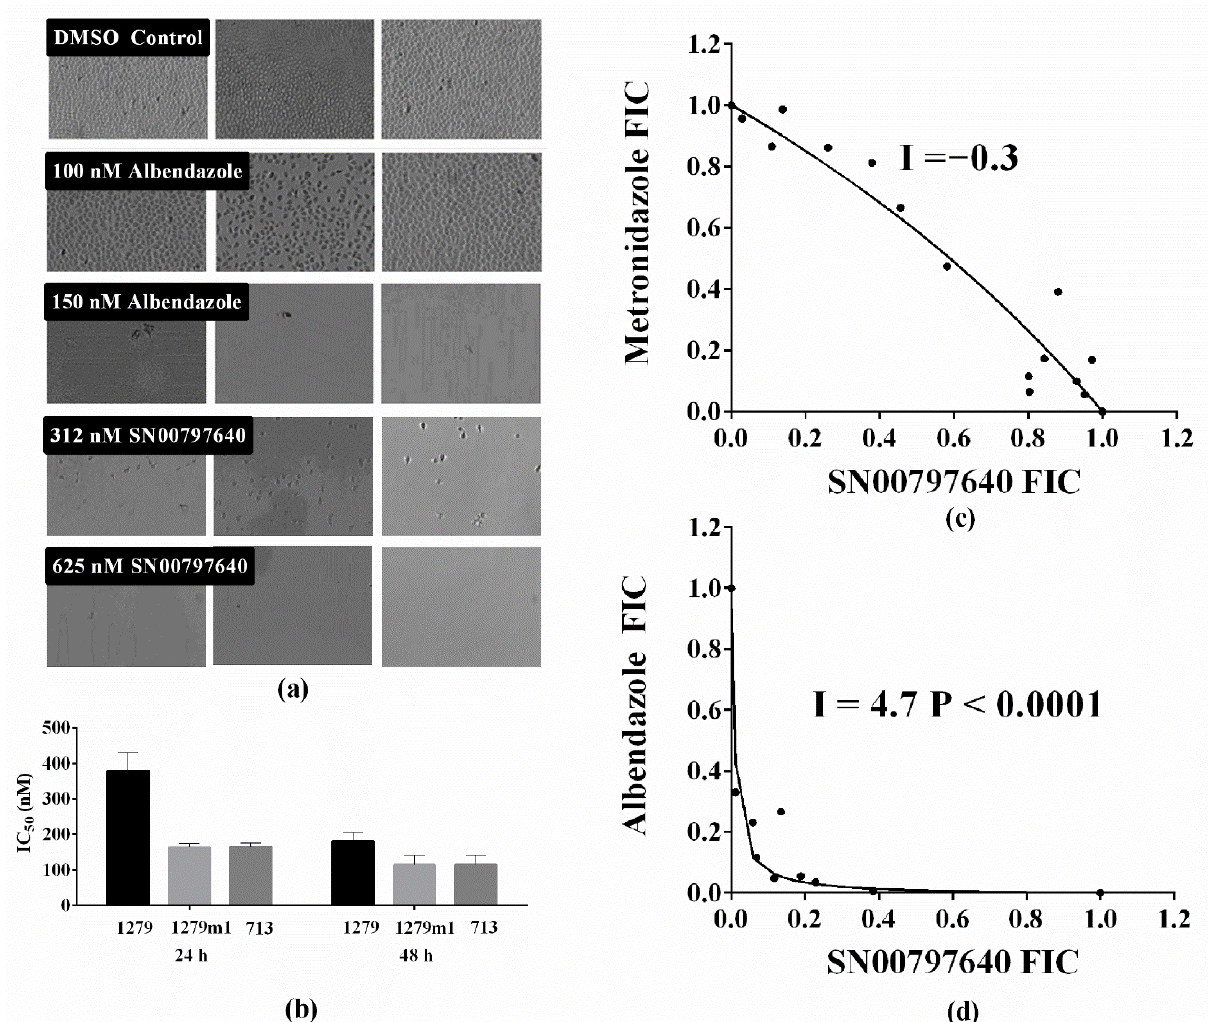
Figure 2. Anti- Giardia activity of SN00797640. To further investigate the potential of scaffold CL9406 compounds the activity of SN00797640 against G. duodenalis was further investigated. ( a ) Images of parasites exposed to SN00797640, albendazole or DMSO demonstrated parasiticidal activity and SN00797640 to have a sub-µM minimum lethal concentration; ( b ) The activity (IC 50 + SD) of SN00797640 against the assemblage B, A, and metronidazole tolerant G. duodenalis cell lines, BRIS/91/HEPU/1279, BRIS/87/HEPU/713 and BRIS/91/HEPU/1279m1, respectively; ( c ) Isobologram demonstrating the additive anti- Giardia activity of SN00797640 when combined with metronidazole; ( d ) Isobologram demonstrating the synergistic anti- Giardia activity of SN00797640 when combined with albendazole.